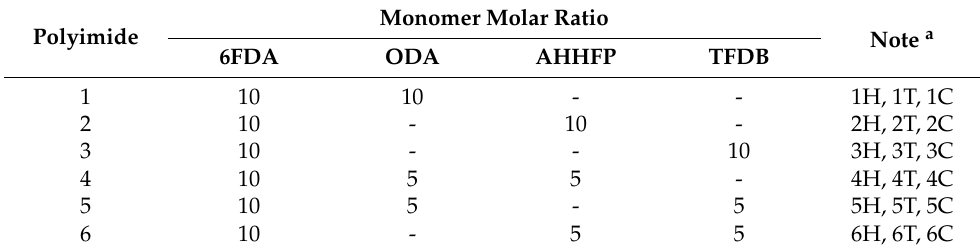
Monomer Molar Ratio